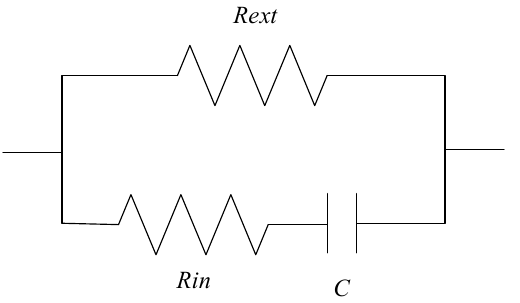
Figure 3. Equivalent circuit of a knee. R ext models the extracellular liquids, R in the intracellular liquids and C the capacitance of the cellular membrane.